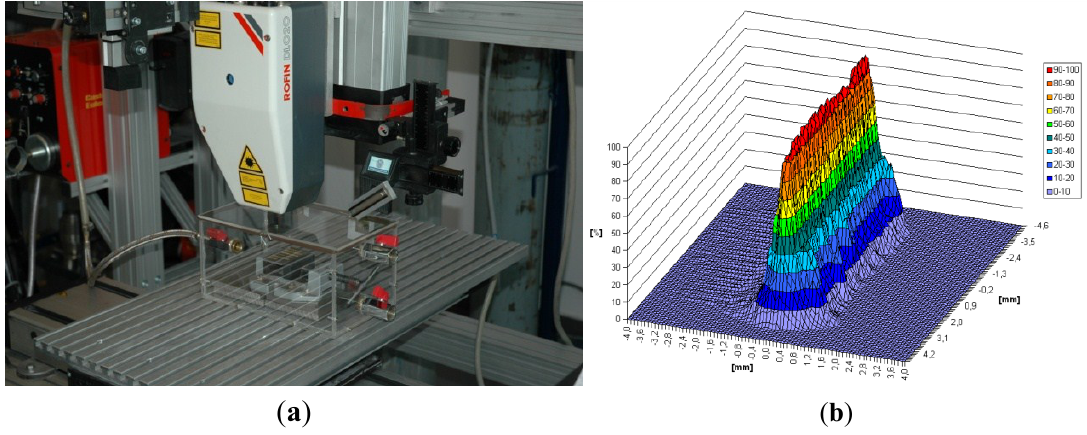
Figure 2. ( a ) A view of the experimental setup equipped with the continuous wave high power direct diode laser (HPDDL) ROFIN DL 020; ( b ) 3D laser beam intensity profile (energy distribution) determined at the focal plane (beam spot) for the applied laser. Table 1. Technical data of the continuous wave (CW) high power direct diode laser ROFIN DL 020. Parameter Value Wavelength of the laser radiation (nm)